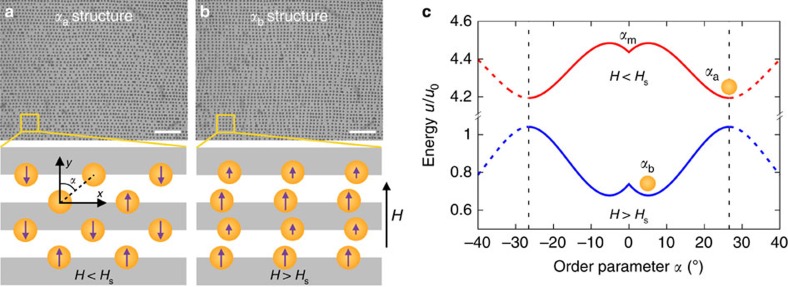
Landscape-inversion phase transition in dipolar colloids on a periodic magnetic substrate.(a,b) Experimental image and sketch of the dipolar colloidal crystal at external magnetic fields H lower and higher than the substrate field Hs=13 kA m−1. Particles assemble into lines, on top of the walls between oppositely magnetized domains (white and grey) of the substrate, with spatial period λ=2.6 μm. The structural order is described by the lattice angle α. Scale bars, 20 μm. (c) The energy landscape of the system completely inverts for H>Hs. This induces a transition from the αa to the αb structure in the crystal20. A metastable equilibrium structure, αm, exists for H<Hs. Dashed lines illustrate the identification αa↔−αa, since these angles correspond to the same structure (see text). The energy scale is u0≡μ0χ2a3, with χ∼1 the magnetic susceptibility of the particles of radius a=0.5 μm.